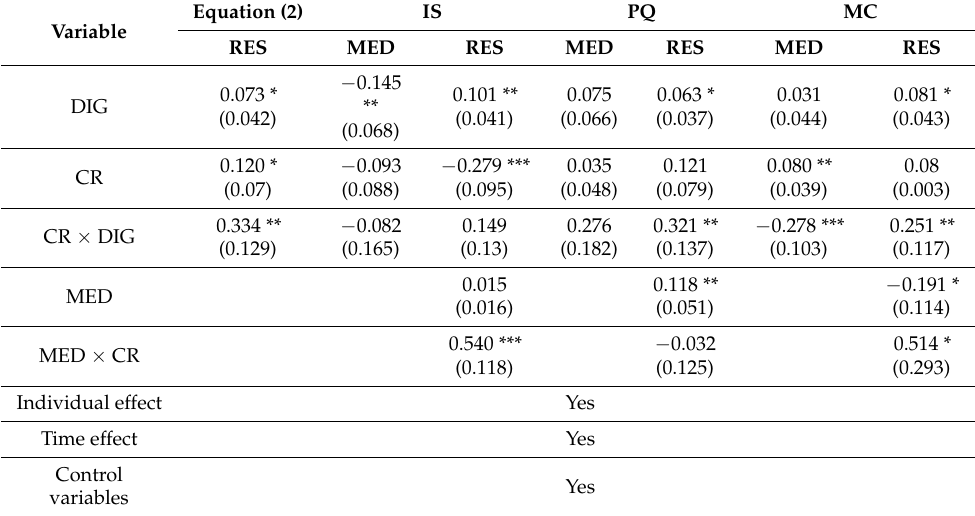
Table 7. Stepwise regression is used to test the moderated mediation